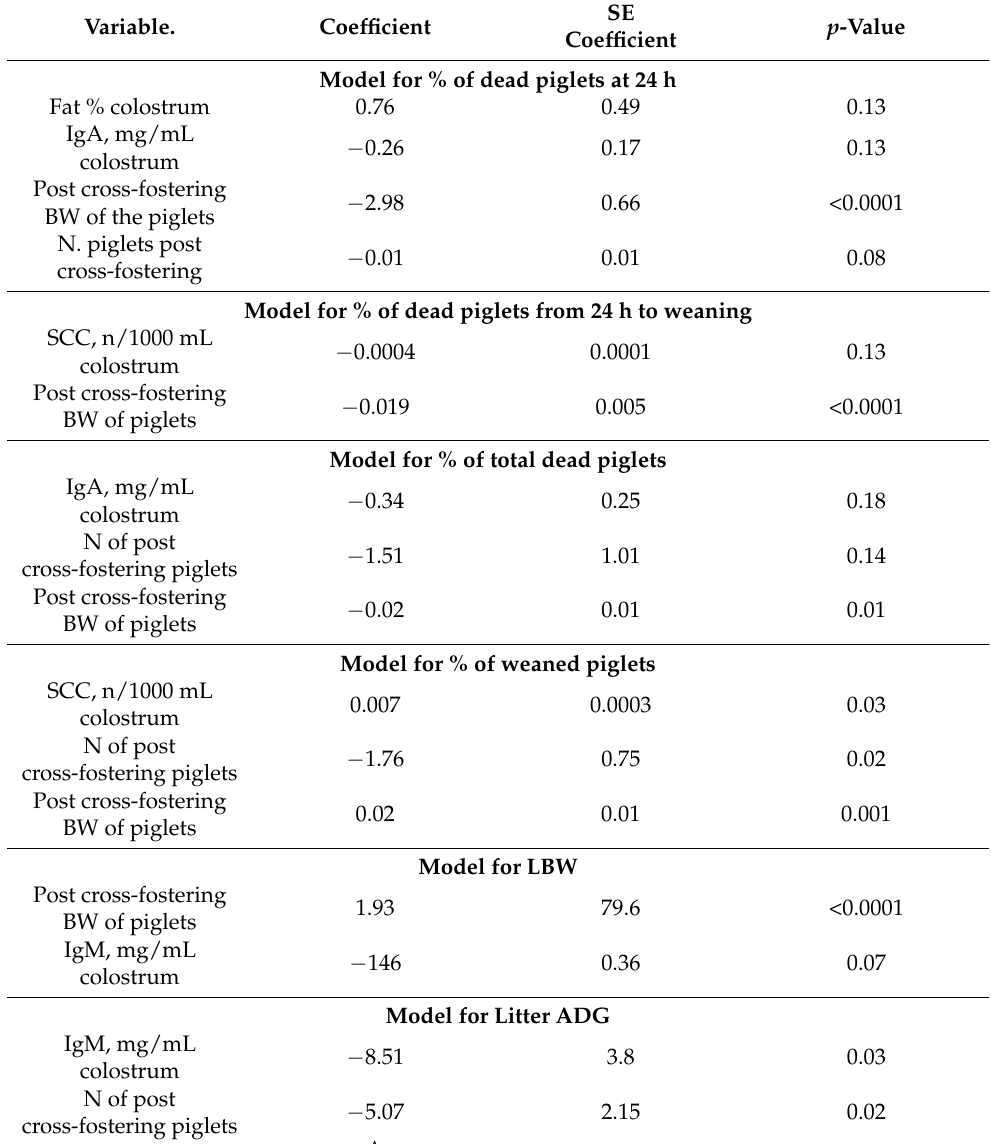
Table 5. Results of the ANOVA analysis regarding sow performance at 24 h, 2 days post-farrowing, and weaning.